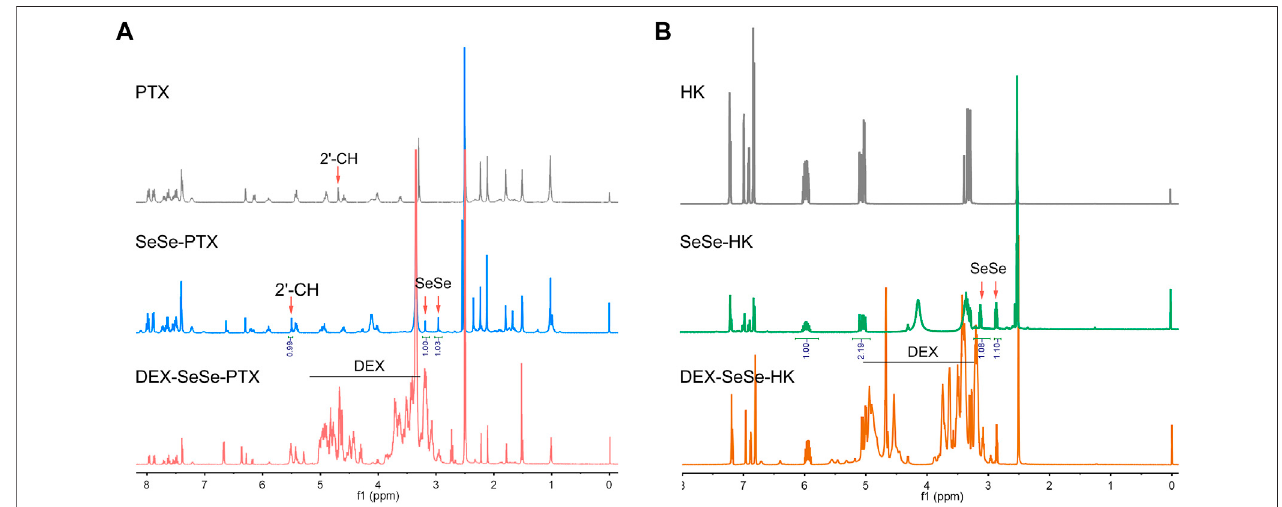
FIGURE 2 | Characterization of polymeric prodrugs. (A – B) 1 H nuclear magnetic resonance spectrums of parent drugs and polymeric prodrugs in dimethyl